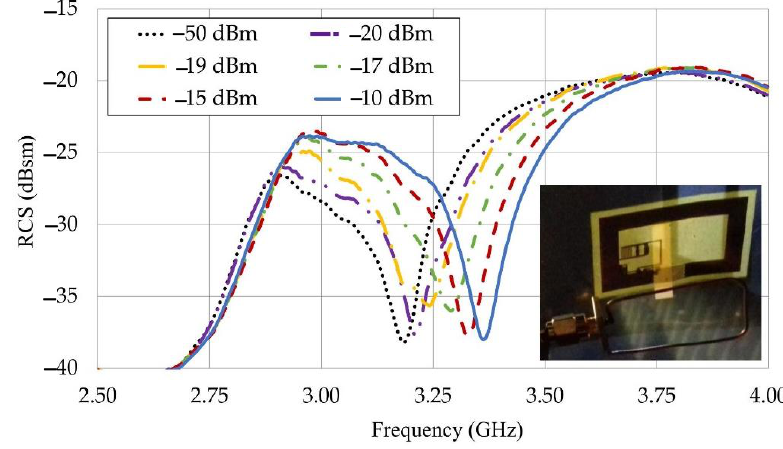
Figure 12. Measured RCS for different values of input power P g .